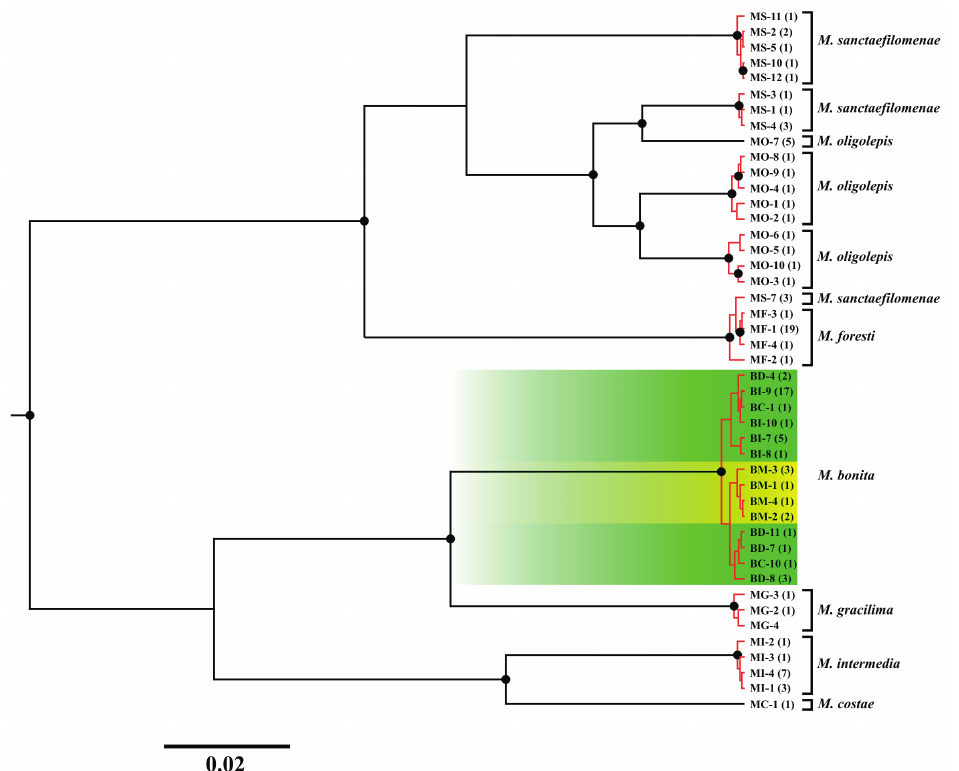
Figure 4 - Bayesian ultrametric tree of the COI gene and delimitation of OTUs of Moenkhausia , according to the GMYC test (specimens in red represent same cluster inferred by GMYC). Circles represent a posteriori probability > 95%. Only the sequences of the COI of M. bonita specimens were obtained in this study, the others were obtained from Genbank (Table SI). Green: Moenkhausia bonita from the upper Paraná river. Grey: Moenkhausia bonita from the